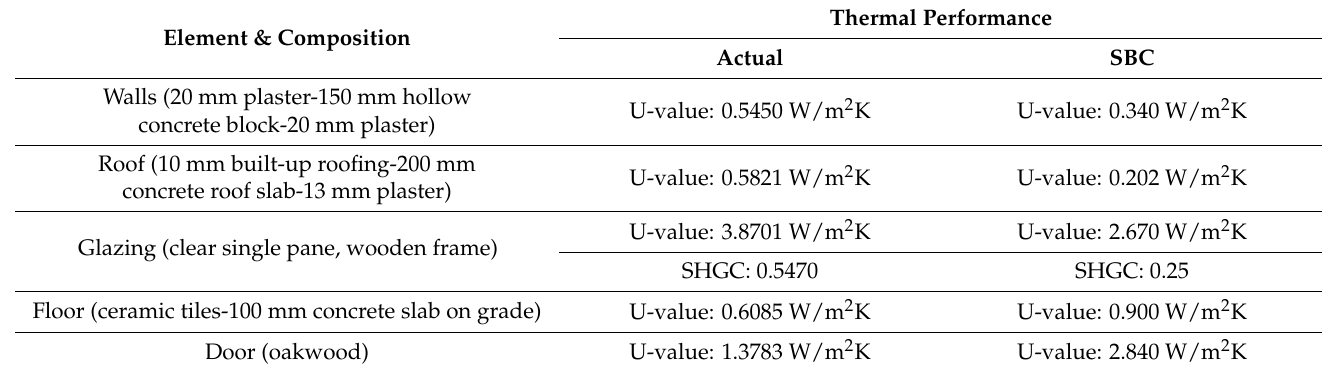
Table 5. Thermal specifications of the selected archetypical baseline building (the u-values were estimated using IES-VE). Element &